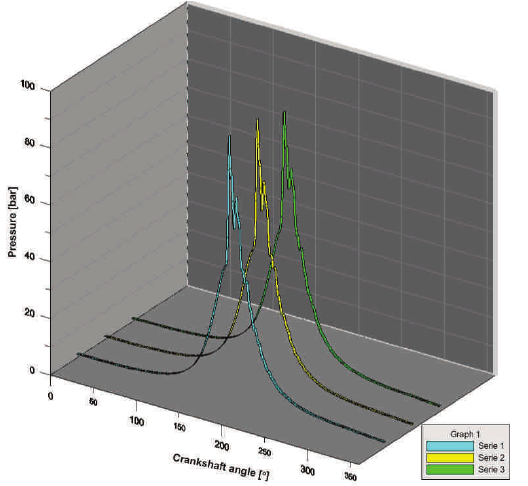
Fig. 3. Pressure changes in the cylinder – tests I, II and III Table 1. Results of pilot research carried out on the engine with an applica- tion of the electronic indicator Engine performance No.